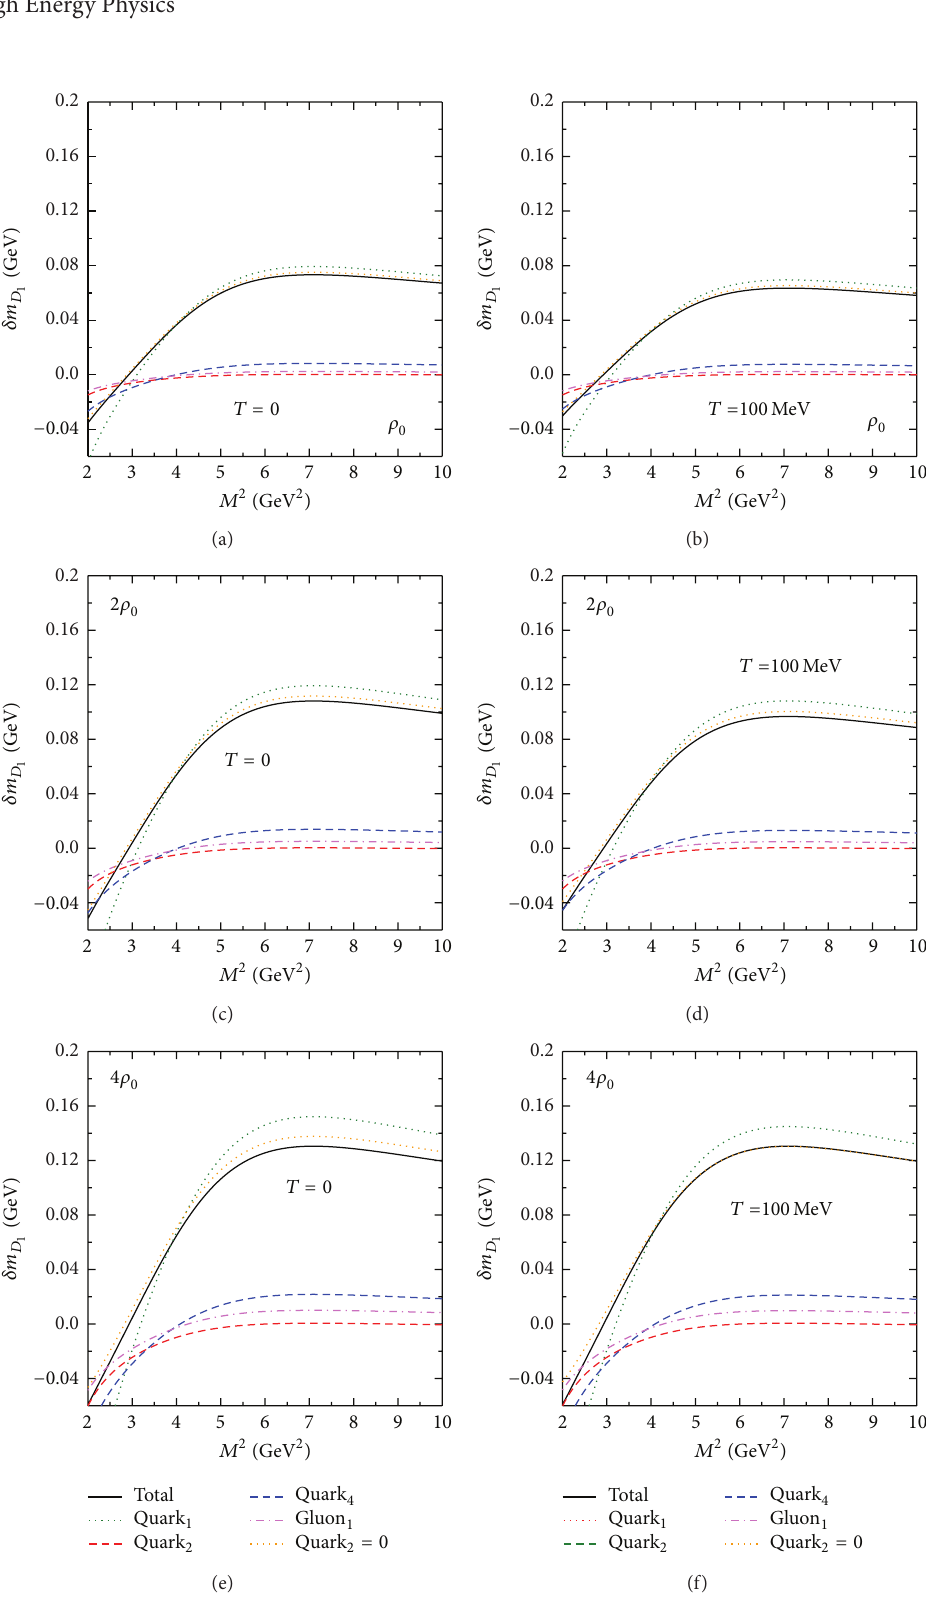
Figure 8: (Color online) Figure shows the contribution of individual condensates to the mass shift of axial-vector mesons 𝐷 1 as a function of the squared Borel mass parameter, 𝑀 2 . The subplots (a), (c), and (e) show the results at temperature 𝑇 = 0, whereas the subplots (b), (d), and (f) are plotted for temperature 𝑇 = 100 MeV. We have shown the results at baryon densities 𝜌 0 , 2𝜌 0 , and 4𝜌 0